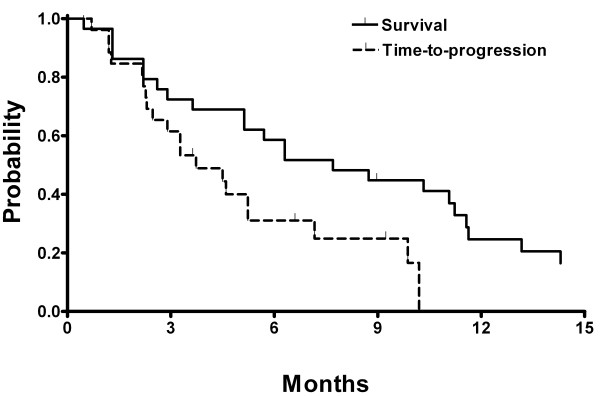
Overall survival and time to progression.